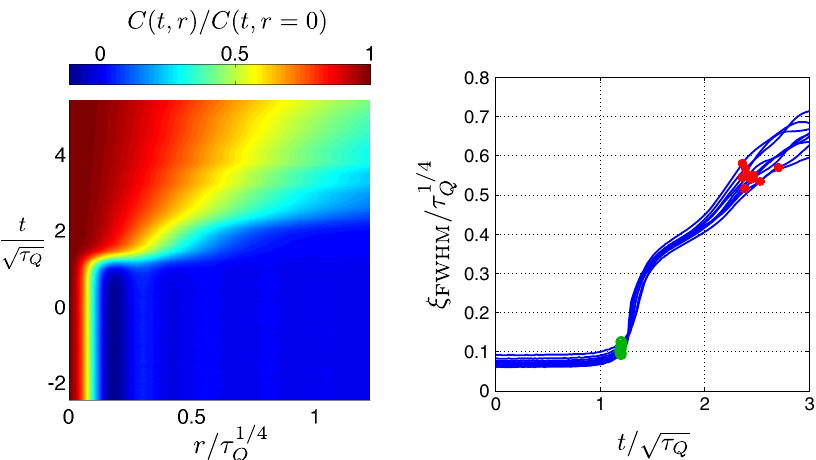
4 τ . Right: The time evolution of the full width at half maximum ξ Q ¼ o t while the red stars correspond to ξ FWHM ð freeze Þ ≫ ξ t t . The collapse of all curves between t FWHM ð freeze Þ FWHM ð eq Þ